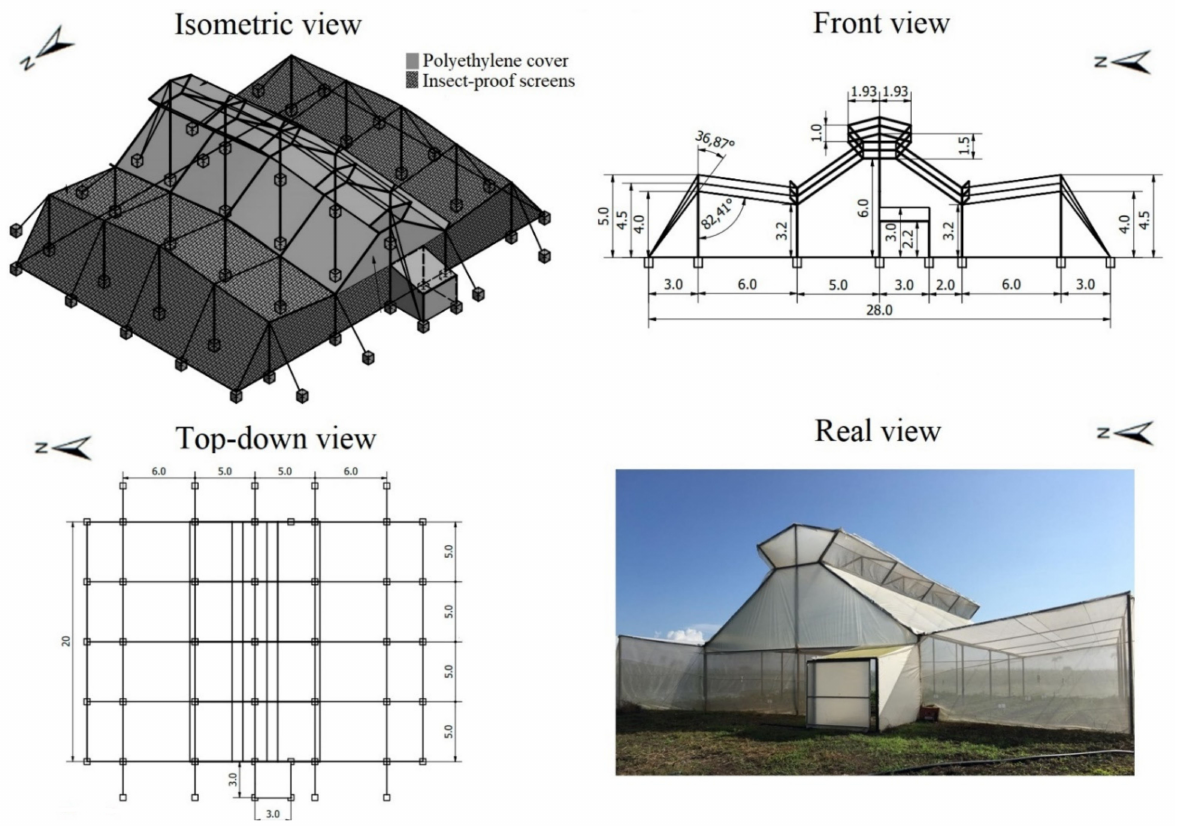
Figure 1. Overall dimensions and actual view of the evaluated structure.